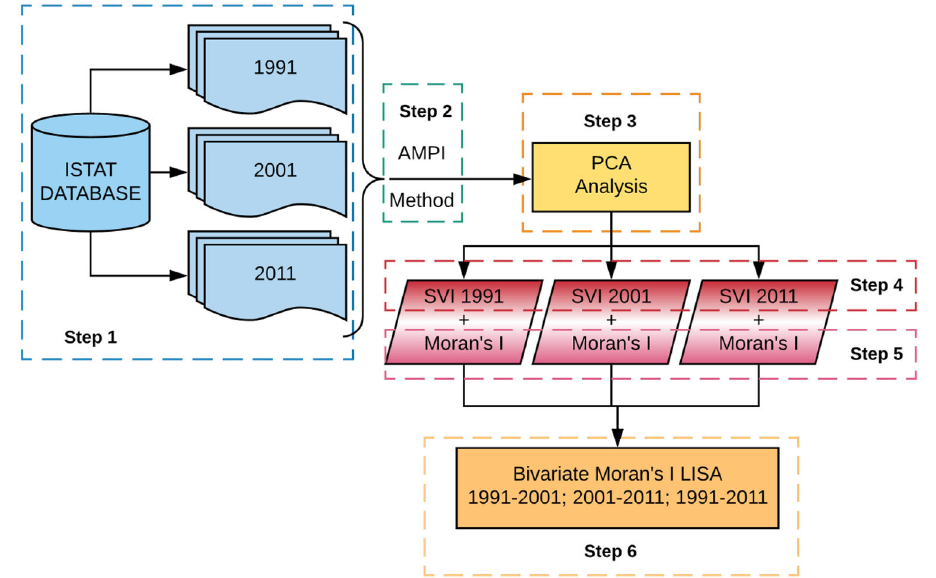
Fig. 1 Flowchart of the methodology used to study Italy’s spa- tiotemporal pattern of social vulnerability. The first step selects variables and social vulnerability indicators starting from the Italian National Institute of Statistics (ISTAT) database. Subsequently, the indicators were normalized with the adjusted Mazziotta–Pareto index (AMPI) method in order to process them with a principal component